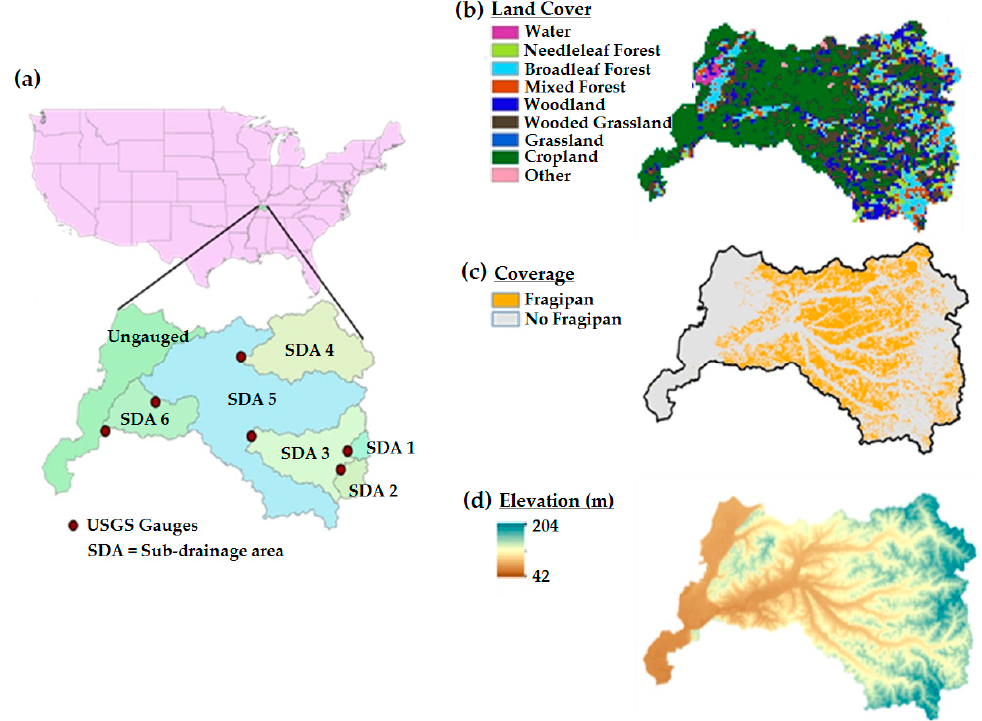
Figure 2. The Obion River Watershed: ( a ) location of watershed, sub-drainage areas (SDA) and USGS gauging stations, ( b ) land cover of Obion, ( c ) fragipan soils map, and ( d ) elevation map.